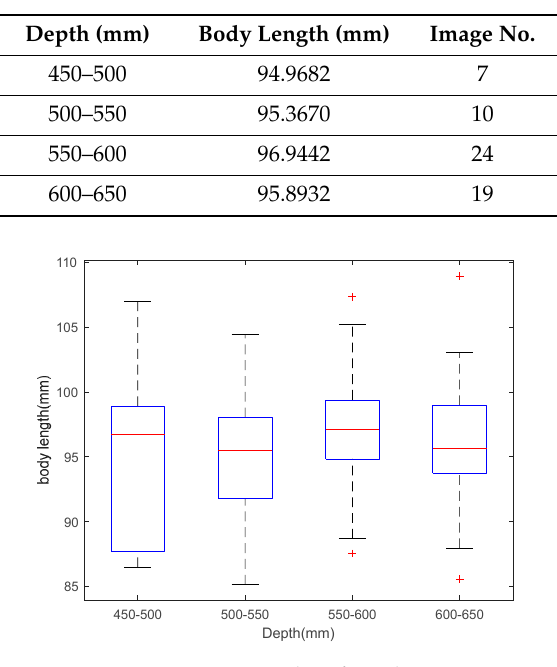
Table 1. The depth and corresponding body length.